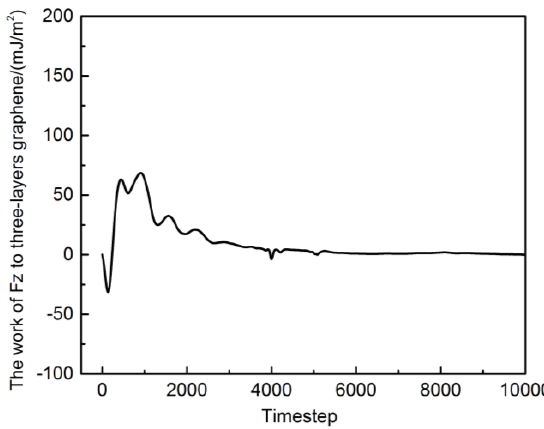
Figure 13. The work of the Fz to exfoliate all three layers of graphene when the upward velocity is 6.98 Å /ps.